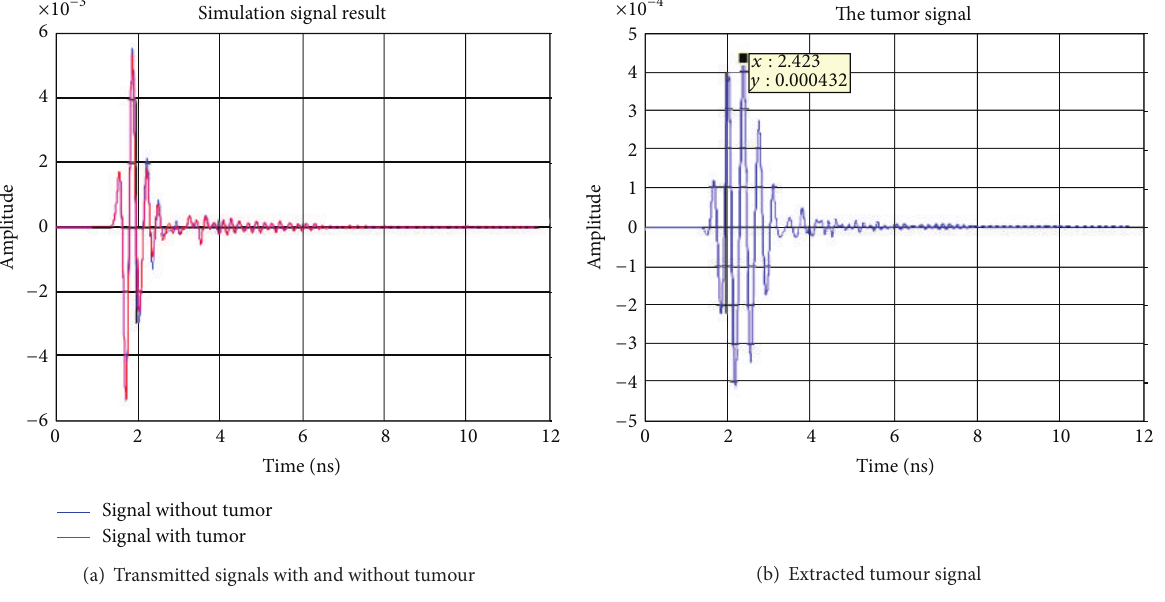
Figure 5: Simulation signal results transmitting from antenna 1 and receiving at antenna 2.